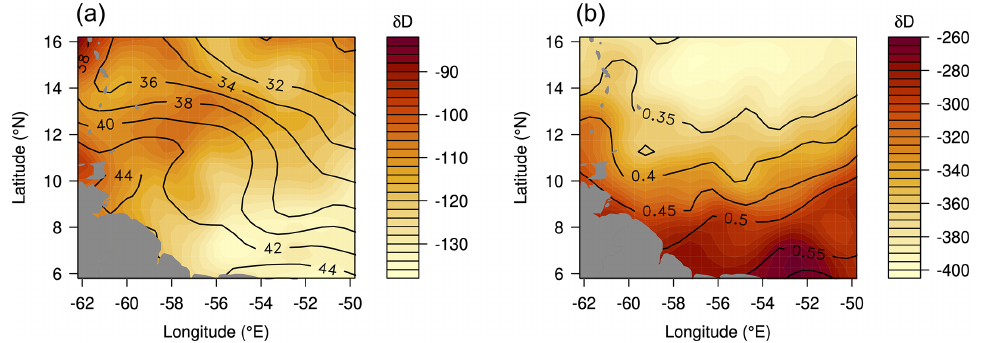
Figure 14. (a) TROPOMI total column δ D (‰, shading) and total column water (kgm − 2 , contours), averaged on a 0.5 ◦ grid and smoothed for the period 11 January–20 February 2020 (DOY 11-51). Only retrievals with a quality value of 0.5 or higher are selected. (b) IASI δ D (‰, shading) and specific humidity (gkg − 1 ; contours) at 6.4km, averaged on a 0.5 ◦ grid and smoothed for the same period. (Note that the two water vapor fields represent distinct quantities.) Only data marked “good quality” in terms of spectral fit are